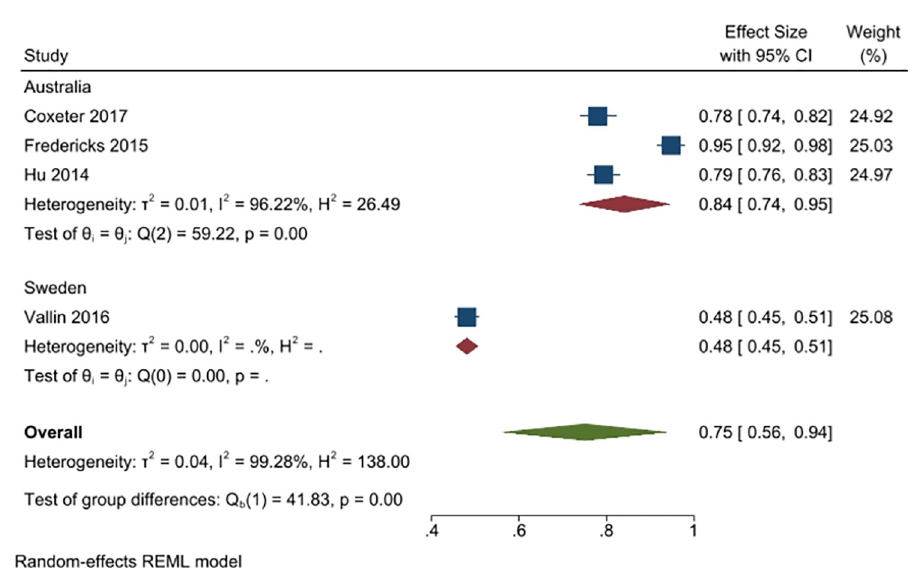
Fig 8. Percentage of respondents answering yes to the question whether antibiotics have adverse events or harms associated with their use.